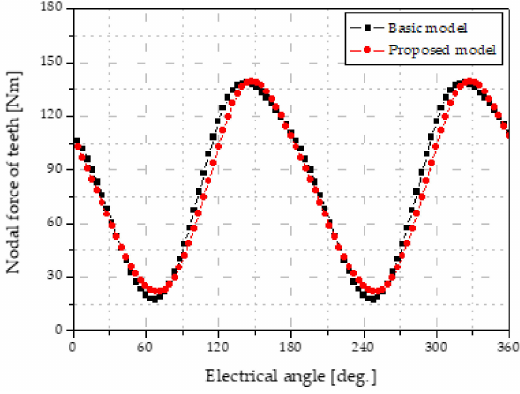
Figure 15. Comparison of the nodal force at the load condition. Table 7. Comparison of nodal force of basic and proposed